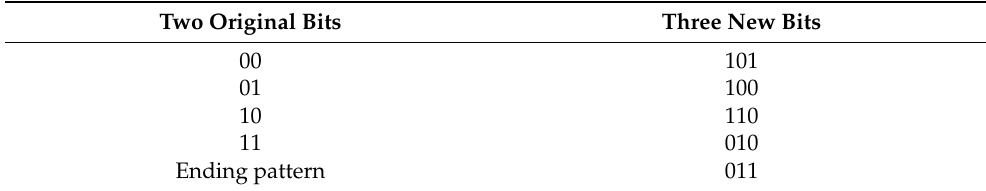
Table 2. A mapping table that transforms two bits of the original message data into three